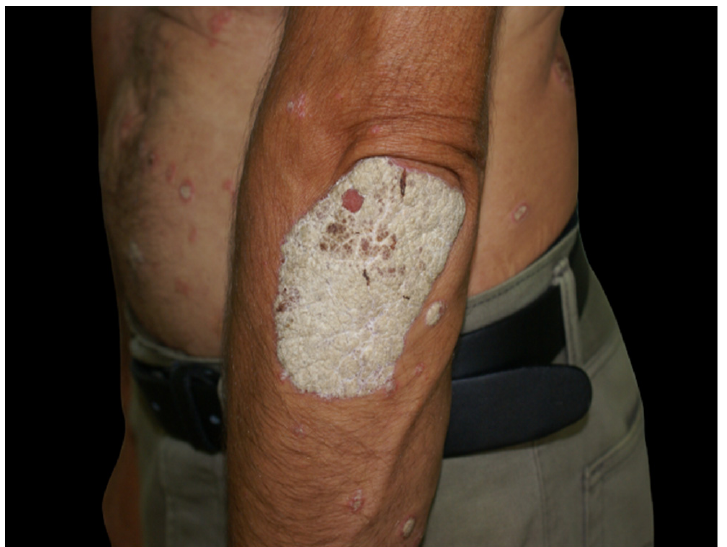
Figure 1. Round to oval, well-defined psoriasis plaque on the left elbow covered by a thick, silvery scale. Several smaller plaques may also be seen on the trunk.